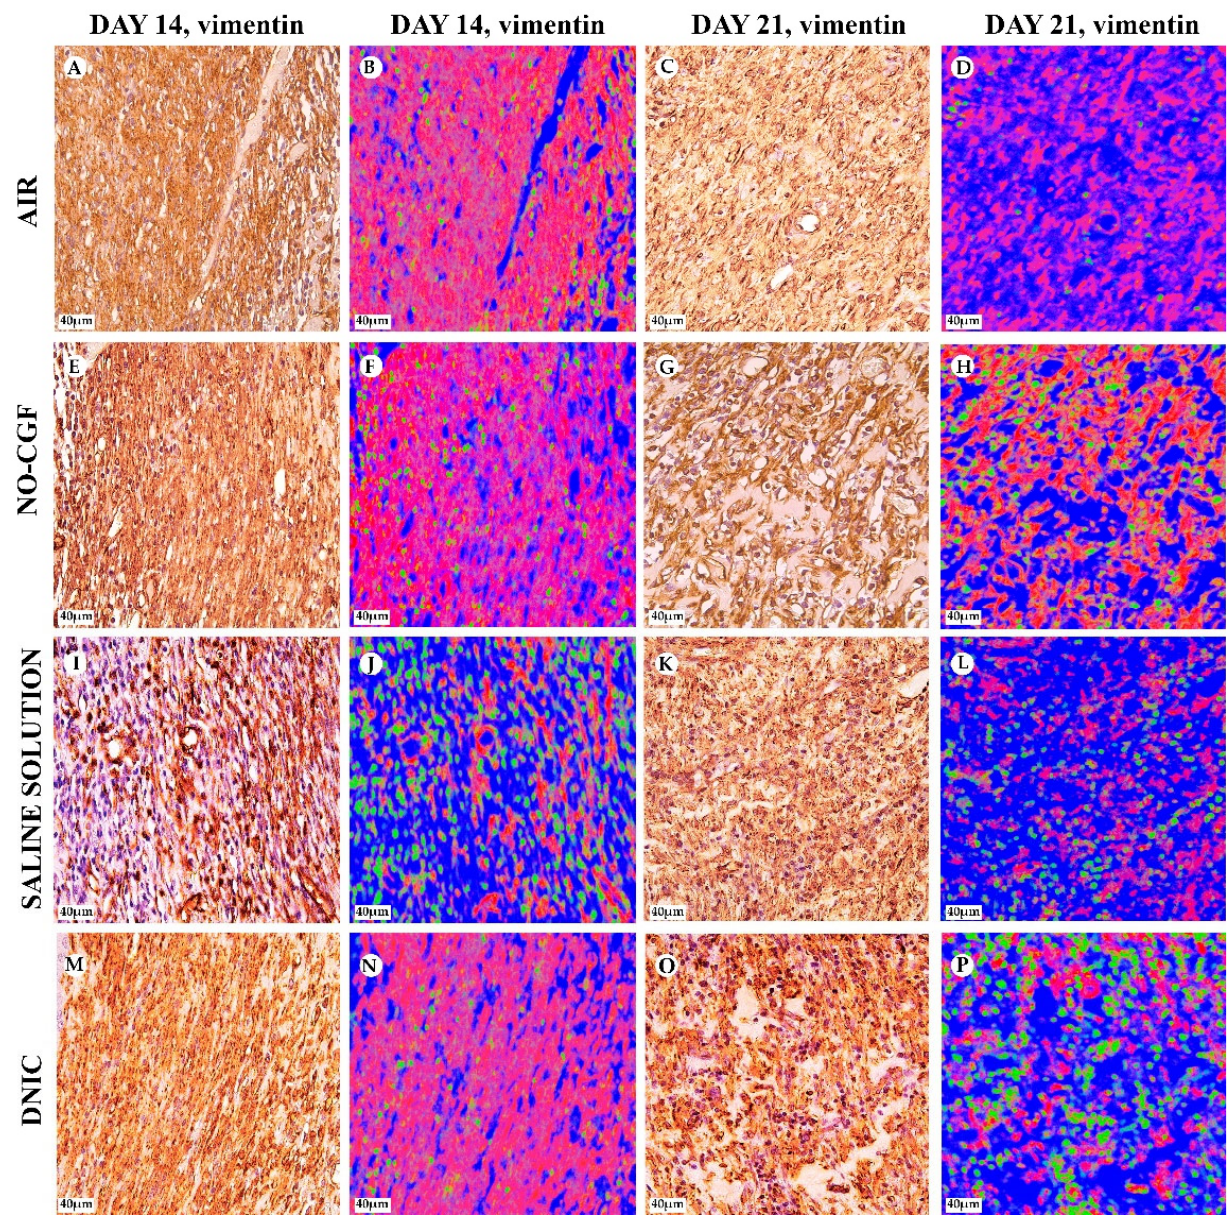
Figure 14. Vimentin expression and vimentin ‐ positive cells’ distribution in the study groups on days 14 ( A , B , E , F , I , J , M , N ) and 21 ( C , D , G , H , K , L , O , P ), magnification ×400. Red—vimentin ‐ positive cells, green—vimentin ‐ negative cells, blue—background. ( A ) Numerous vimentin ‐ positive cells, ( B ) monolayer of red ‐ stained cells, ( C ) weak vimentin expression, ( D ) red ‐ stained areas in mature granulation tissue, ( E ) intensive vimentin expression, ( F ) high content of vimentin ‐ positive cells in mature granulation tissue, ( G ) vimentin ‐ positive spindle ‐ shaped cells along collagen fibers, ( H ) prevalence of red ‐ stained cells, ( I ) vimentin expression in the deep part of wound, ( J ) singular positive cells in granulation tissue, ( K ) low intensity of vimentin expression, ( L ) diffusely arranged red ‐ stained cells, ( M ) prevalence of positive spindle ‐ shaped cells, ( N ) high content of red ‐ stained cells, ( O ) vimentin expression in pericytes and fibroblasts and ( P ) singular red ‐ stained areas.